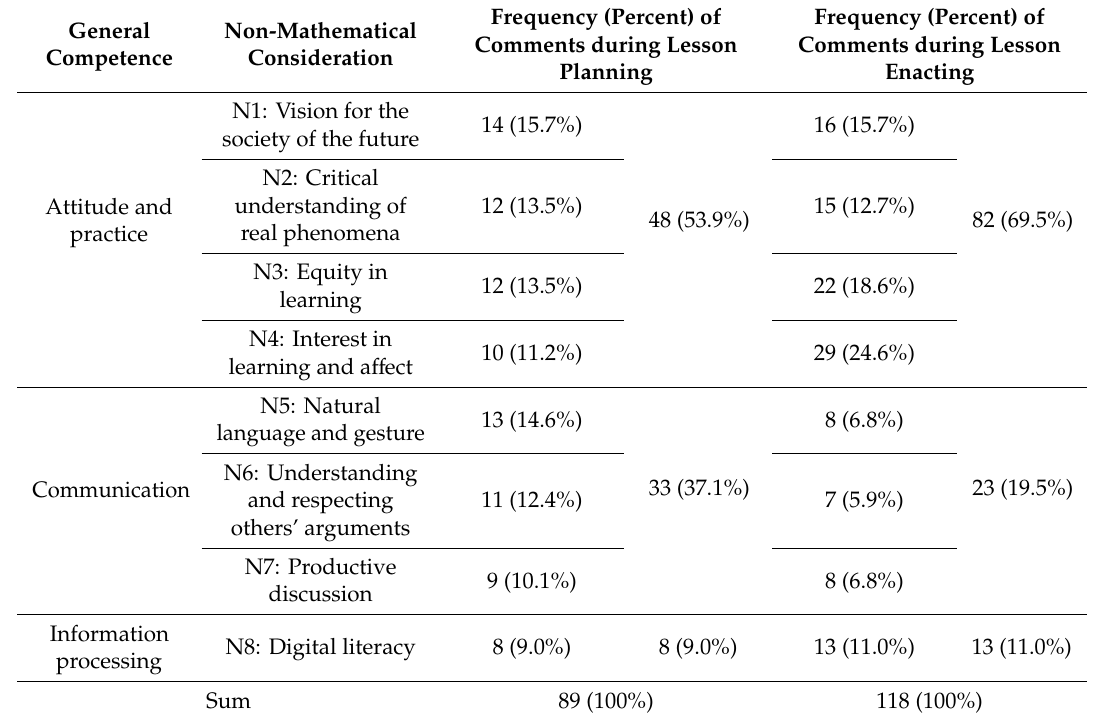
Table 3). The three points M1, M2, and M3 enlarge the o ffi cial curriculum in di ff erent ways to enhance conceptual learning. Kim’s comments in this category of conceptual learning were almost half of the identified mathematics-related pedagogical comments (46.5%), as shown in Table 2. Table 3. Kim’s non-mathematical